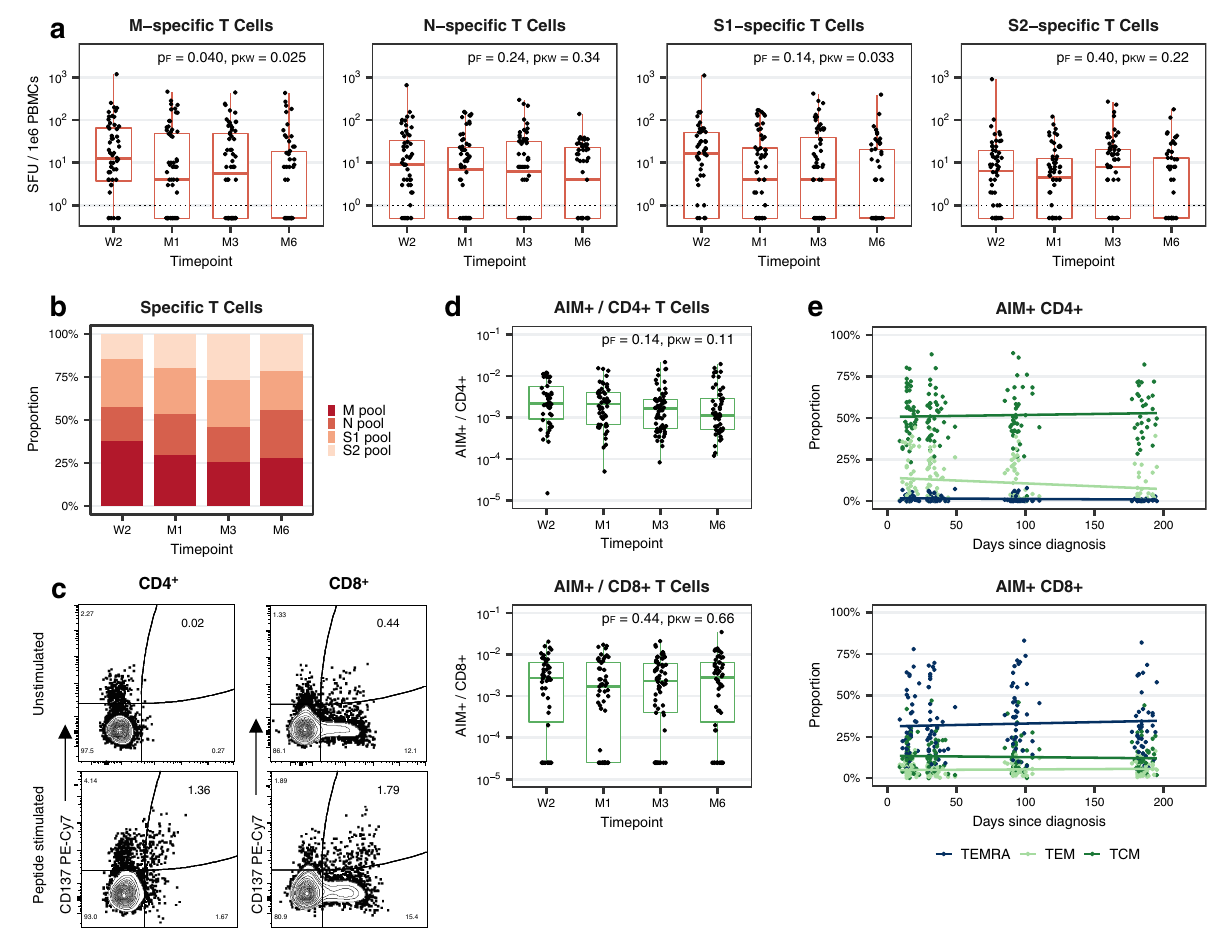
Fig. 4 | T cell responses speci fi c to SARS-CoV-2 M, N, S1, and S2 epitope pools over time. a Number of spot-forming units (SFU) per 1e6 peripheral blood mononuclear cells (PBMCs) following stimulation with M, N, S1, or S2 overlapping peptide pools at indicated timepoints post-diagnosis within the subsample of individuals undergoing detailed testing (total n =64; W2: n =56, M1: n =64, M3: n =64, M6: n =55). Boxplots represent the median and interquartile range (IQR; whiskers: 1.5×IQR). Dotted lines indicate the limit of detection cutoff (SFU values greater than 0). Statistical testing was performed using two-sided Friedman and two-sided Kruskal – Wallis tests to account for both repeated testing and missing data( n =48withcompletefollow-updata).p F : p -valuebasedonFriedmantest,p KW : p -value based on Kruskal – Wallis test, W2: two weeks, M1: one month, M3: three months, M6: six months after diagnosis. b Fraction of the pooled T cell response (summed M, N, S1, and S2 SFU values) speci fi c for each peptide pool at indicated